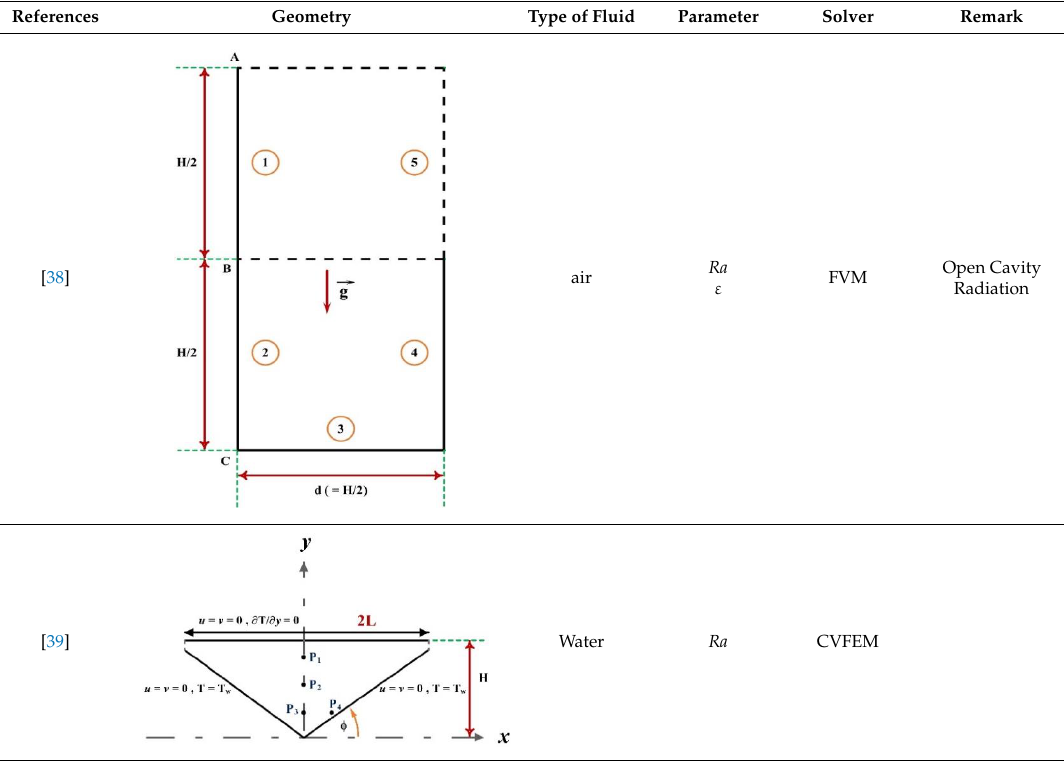
Table 4. Some articles used working fluid of air and water in the enclosures.